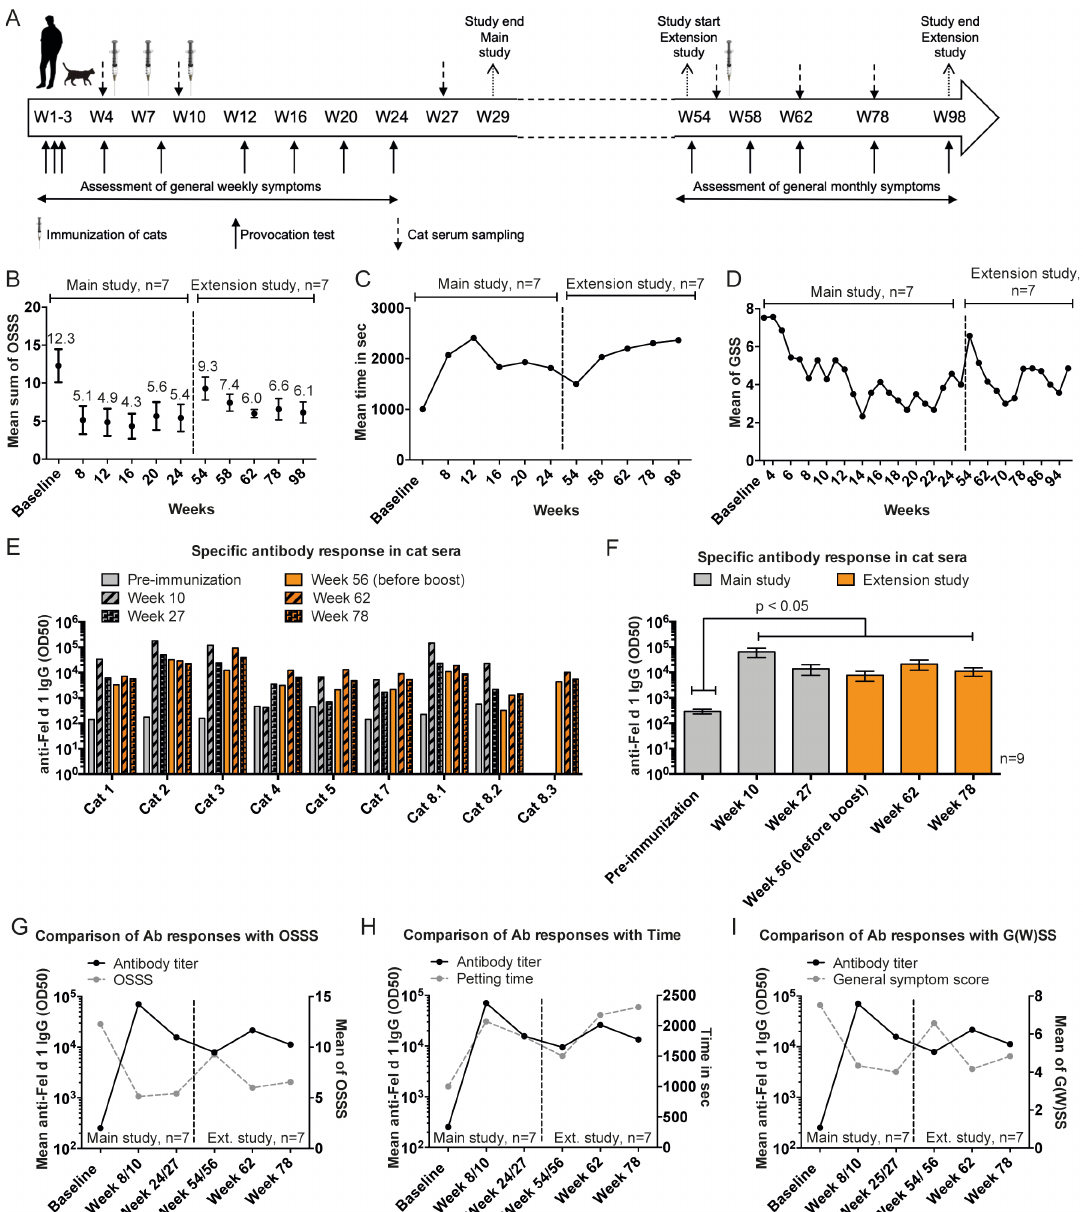
Figure 6. Extension study: Changes in allergic symptoms of participants after booster injection of cats. ( A ) Study design of the main and extension study including seven participants and nine